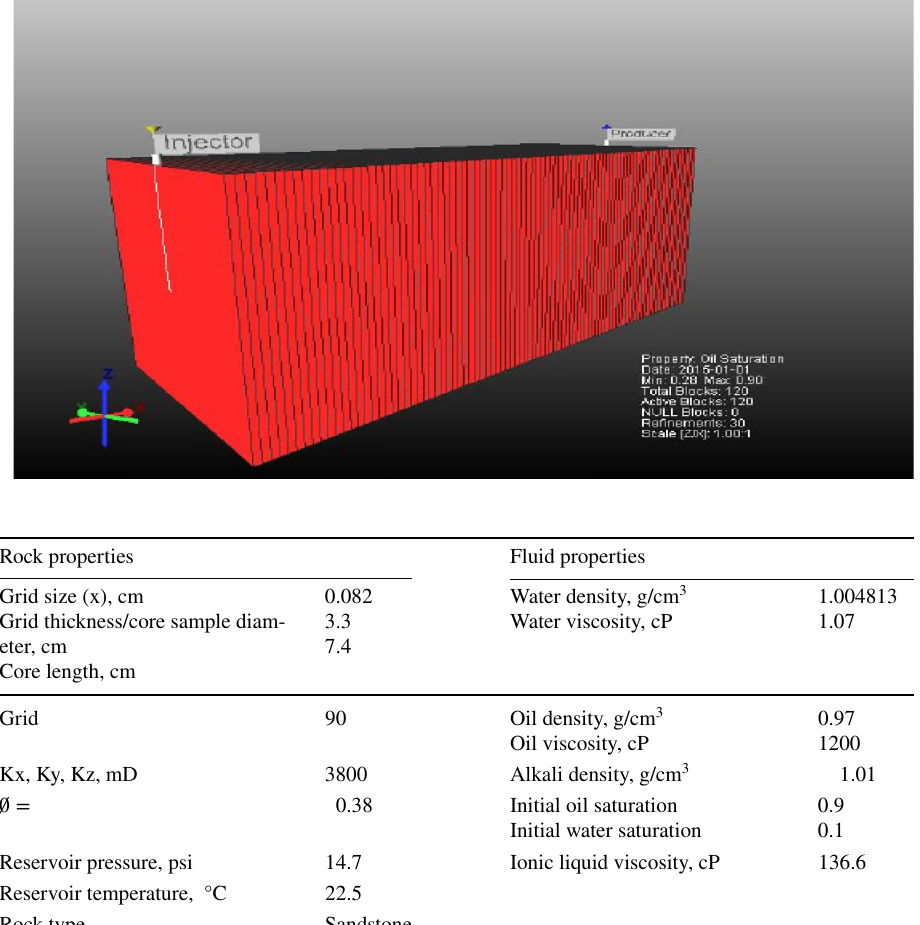
Fig. 1 Cartesian grid design for chemical flooding